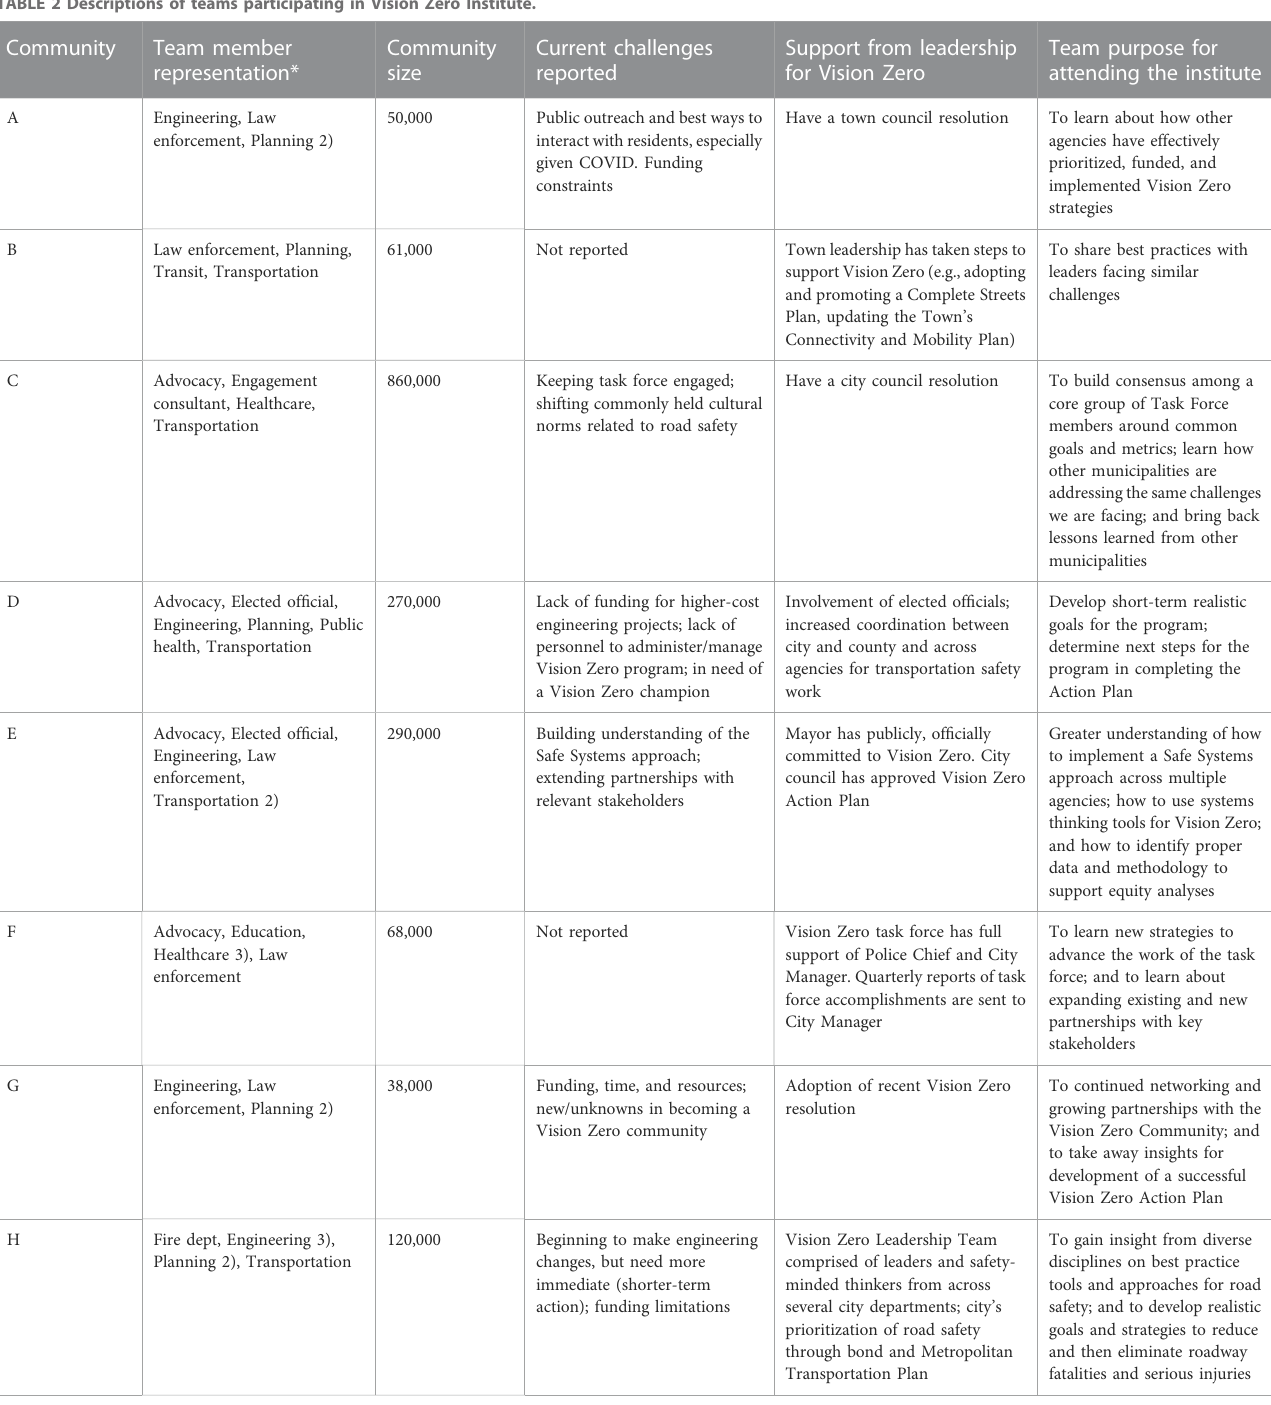
TABLE 2 Descriptions of teams participating in Vision Zero Institute.